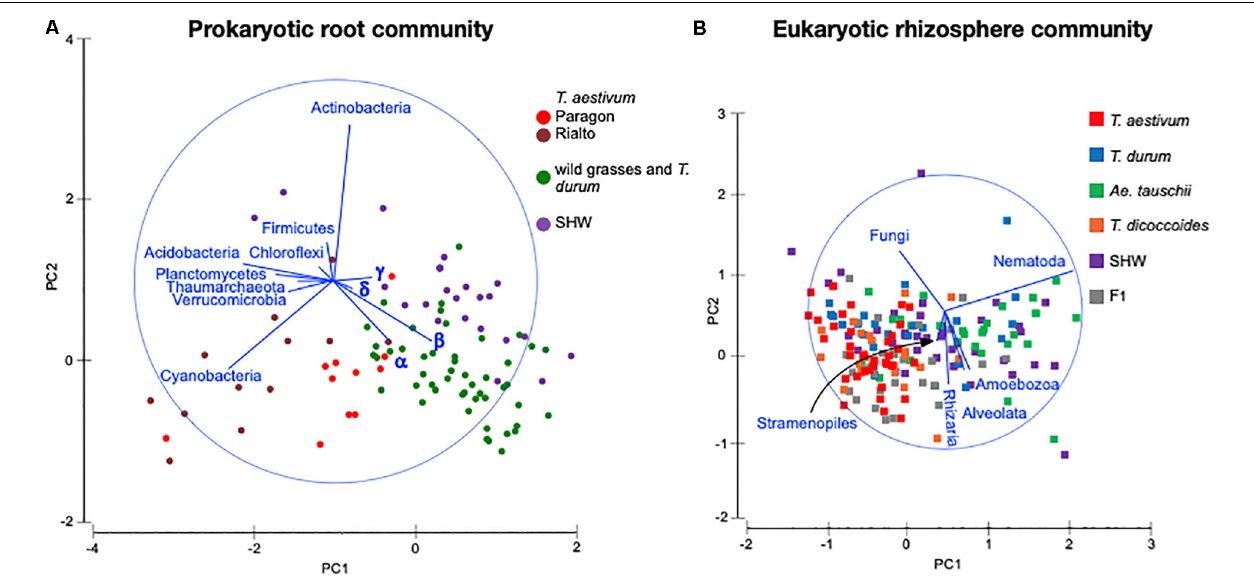
FIGURE 5 | PCA plots of (A) prokaryotic root community and (B) eukaryotic rhizosphere community at the phylum level. Microbiota taxa are used as factors separating plants microbiota structure. The longer the line representing microbial taxa is, the strong effect it has for the sample differentiation. Samples located according to the lines’ directions are influenced by a particular taxon. α – alpha-, β – beta-, γ – gamma-, δ – Deltaproteobacteria.